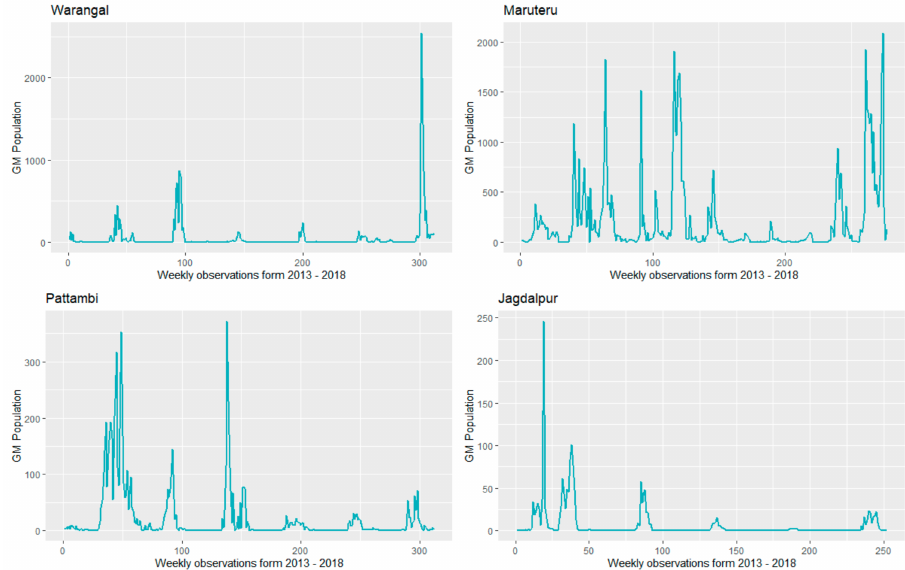
Figure 3. Time series plots of gall midge populations.